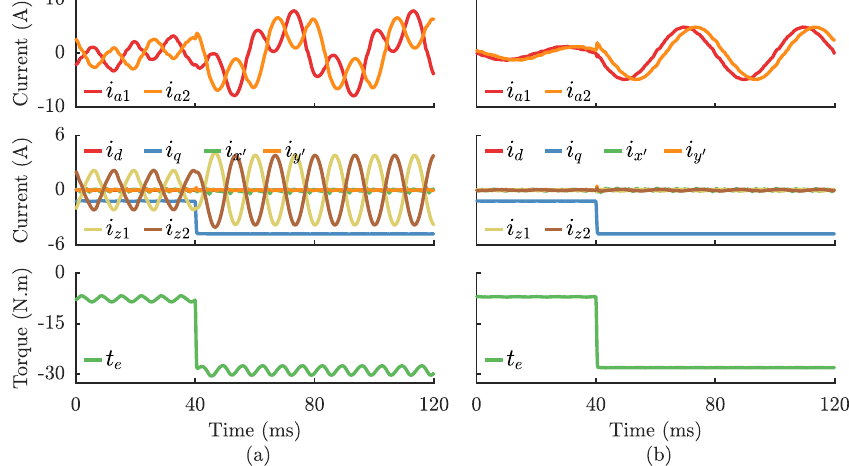
Figure 5. Simulation results for a step change in the q -axis current at 750 rpm, considering the six- phase drive operating under the proposed control strategy with the zero control stage: ( a ) disabled; ( b )